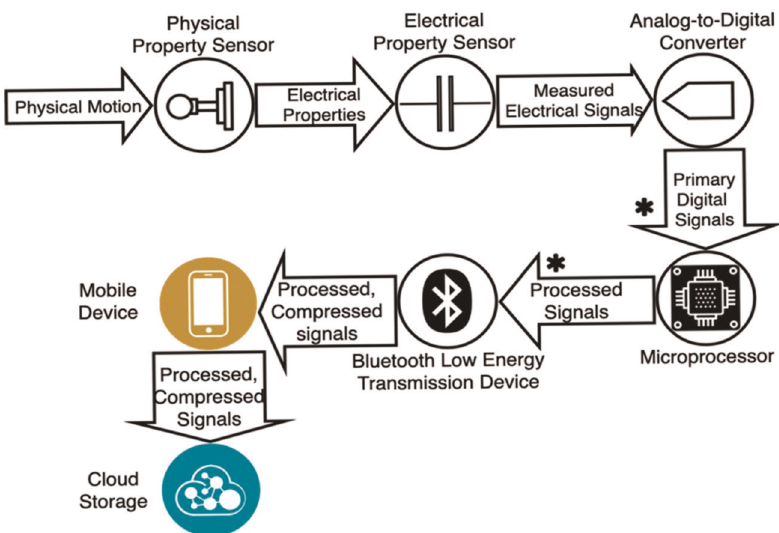
Fig. 2 The “ Raw ” data dilemma: de fi ning sample-level data in the data supply chain in a uniaxial MEMS accelerometer. Acceleration results in physical motion of the equivalence of a spring and proof mass, which in turn results in changes of electrical properties that can be captured by electrical property sensors. Electrical signals are then converted from analog to digital signals and stored and transmitted via the microprocessor on a wristband or mobile device. Through BLE, data are then processed and compressed multiple times for transmission and storage through mobile devices or cloud storage. This fi gure summarizes the steps of data collection and manipulation into a daily step count metric and illustrates that “ raw ” data could refer to different stages of the data collection and manipulation process and have different meanings. For more details of the data types and technologies involved in each step, please refer to Supplementary Table 2. Here, two arrows are highlighted with asterisks, which signify steps in the data supply chain where the “ raw data dilemma ” usually occurs. What is de fi ned and clari fi ed as “ sample-level data ” are the primary and processed digital signals marked by